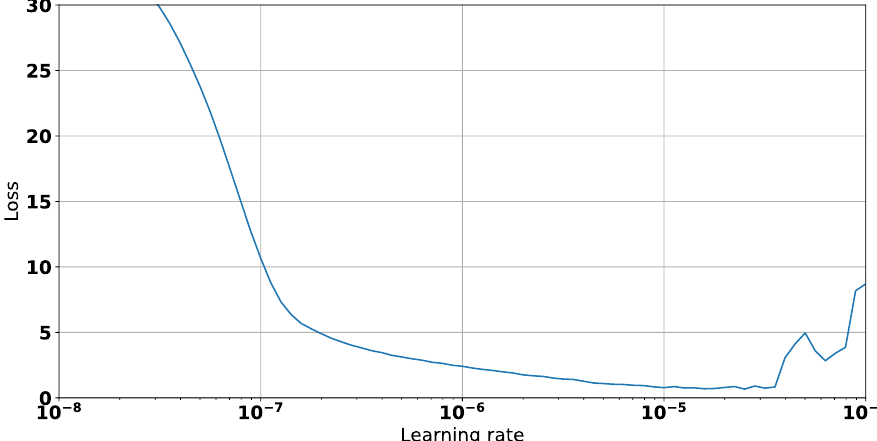
Figure 5. Learning rate schedule output - CNN